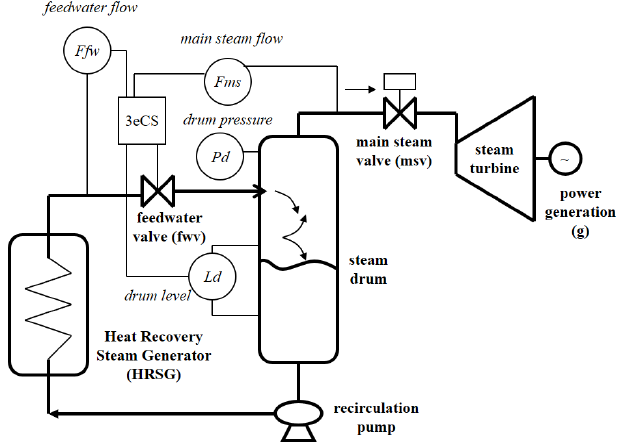
Figure 10. Main components of the steam generation system. The connection to the gas turbine is not